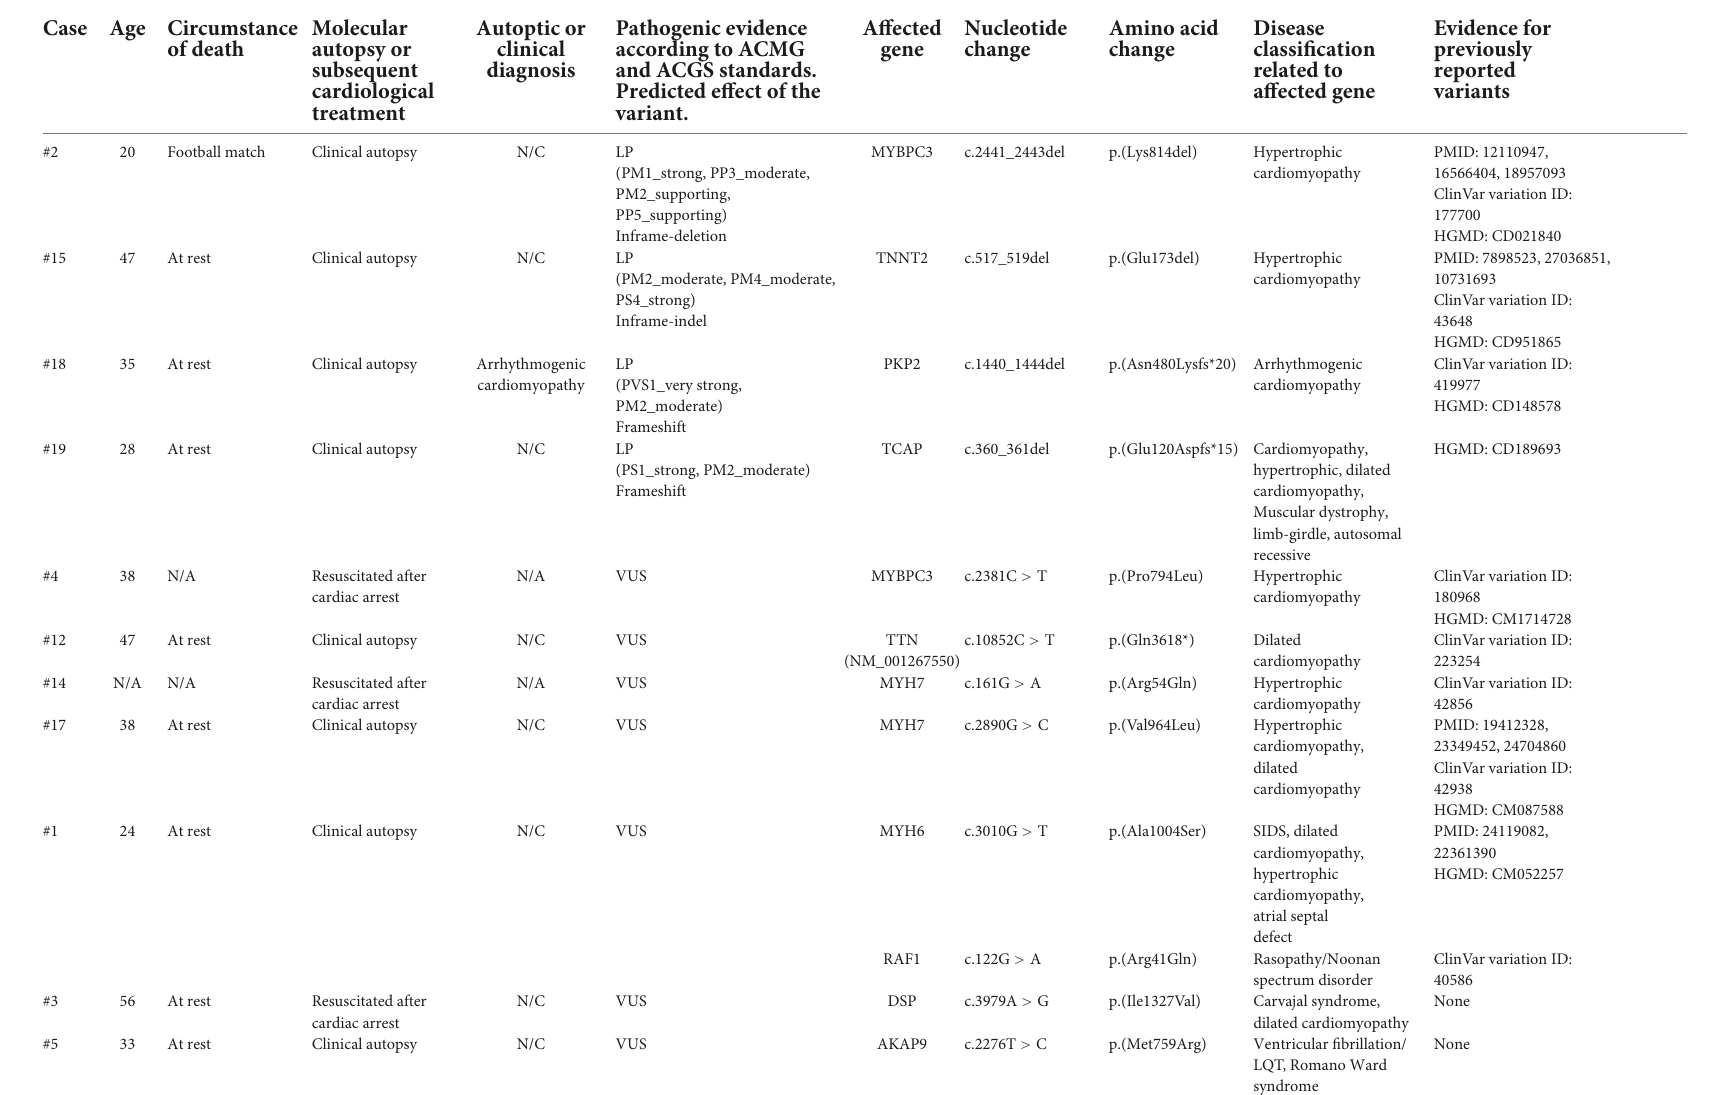
TABLE 1 Genetic findings in the Tuscany registry of sudden cardiac death (ToRSADE)